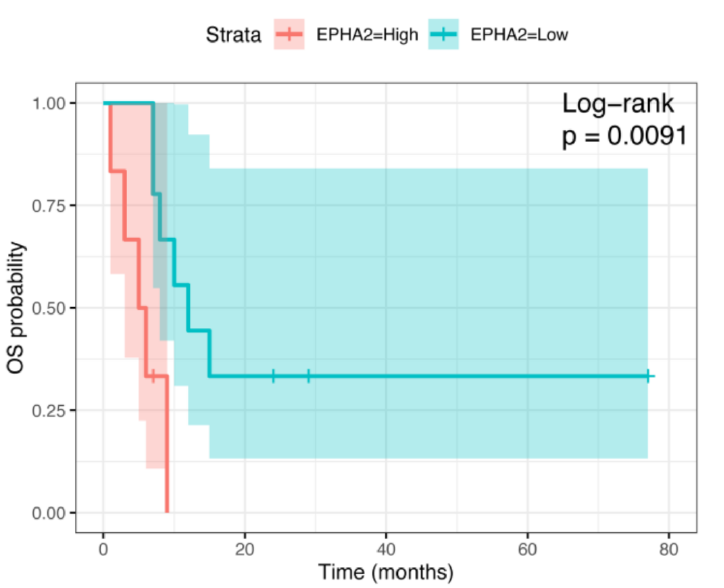
Figure 4. EPHA2 expression levels and overall survival (OS) probability in dedifferentiated chon- drosarcoma group ( n =